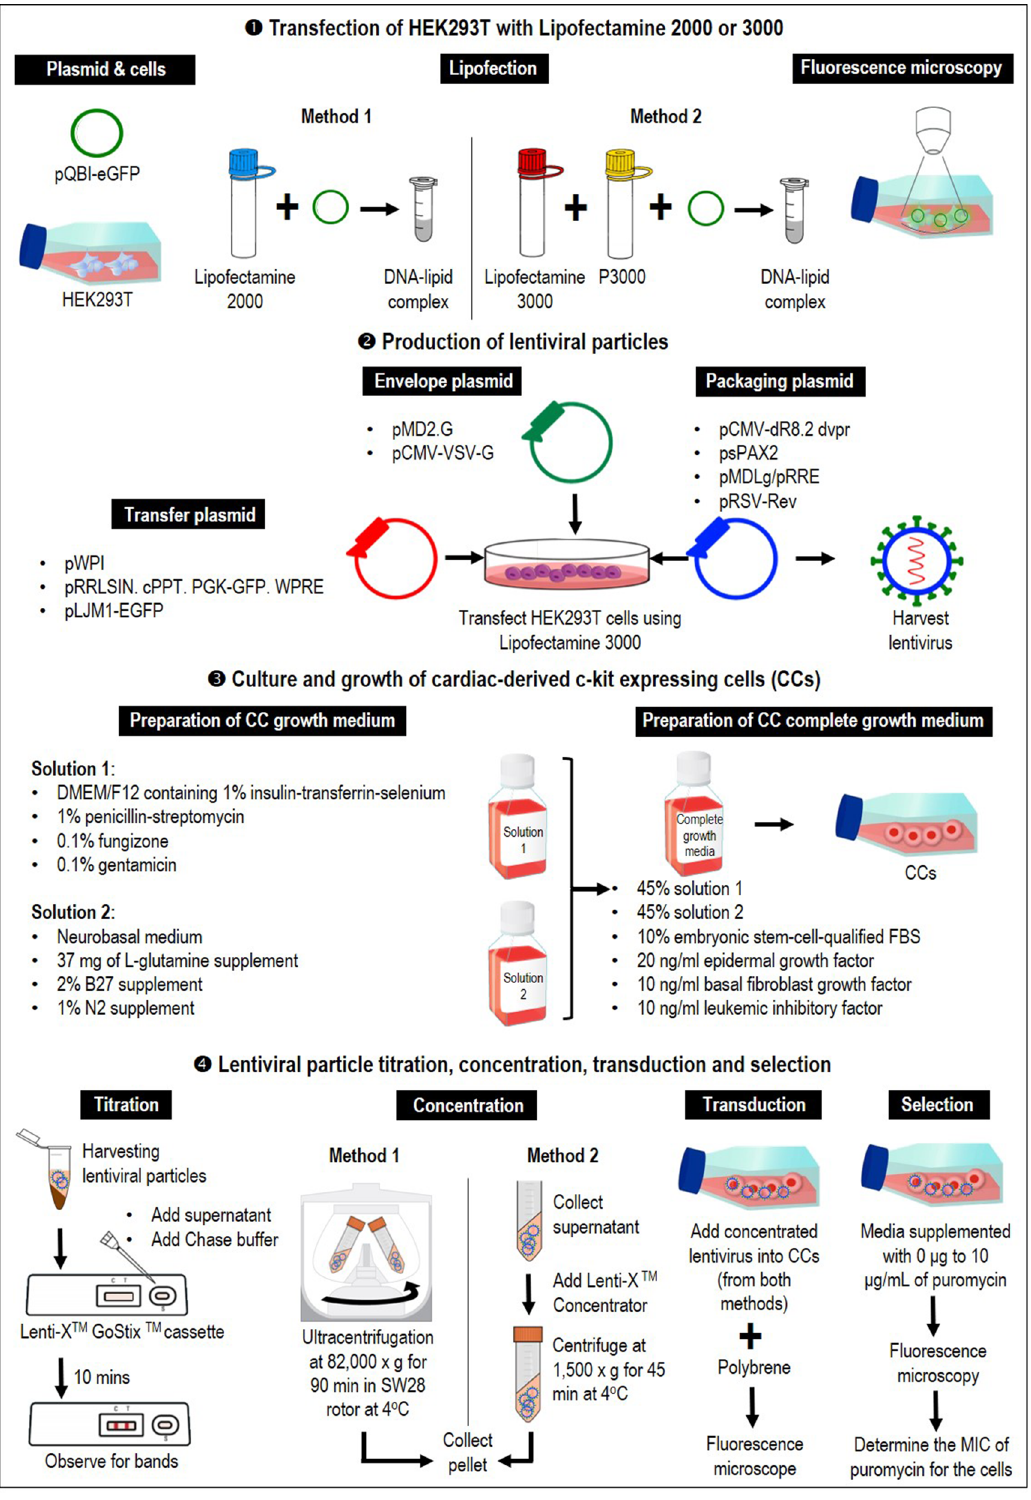
Figure 5. Diagrammatic workflow of the experiment. Preparation of complete growth media for CCs, optimizing different lipofection reagents, lentivirus production and the relative ratio of transfer, packaging and envelope plasmids, viral titering and purification, concentration, as well as selection method of cells carrying the